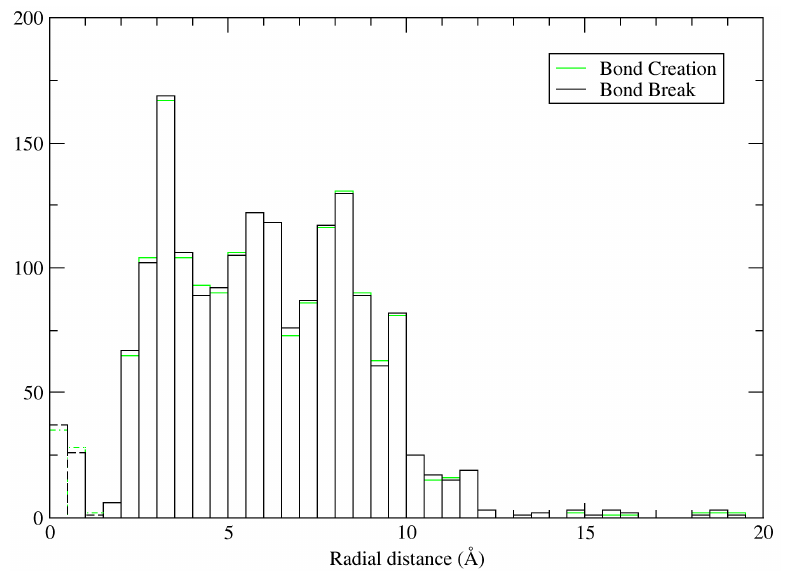
Figure 5. Bond creation/cleavage events by distance to the nanoparticle surface, r OH = 1.2 Å. The y-axis is the number of events that occurred at that distance.